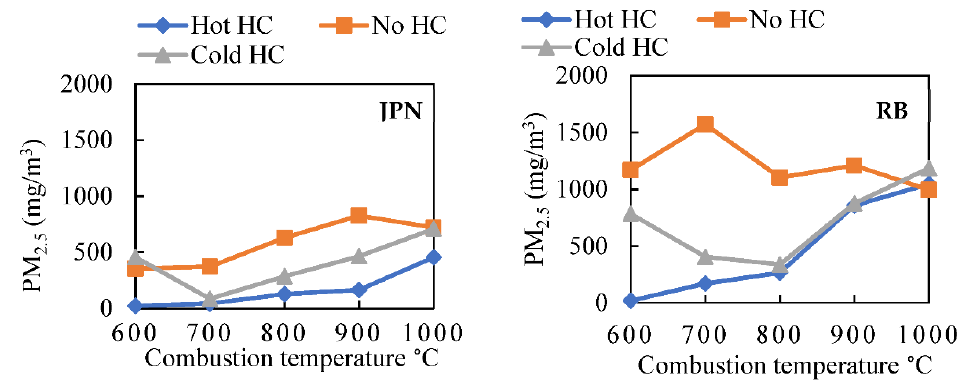
Figure 11. Comparative PM 2.5 analysis from a preheated catalyzed, non-preheated catalyzed, and non-catalyzed combustion of RB and JPN samples. Note: The samples were run in triplicates.